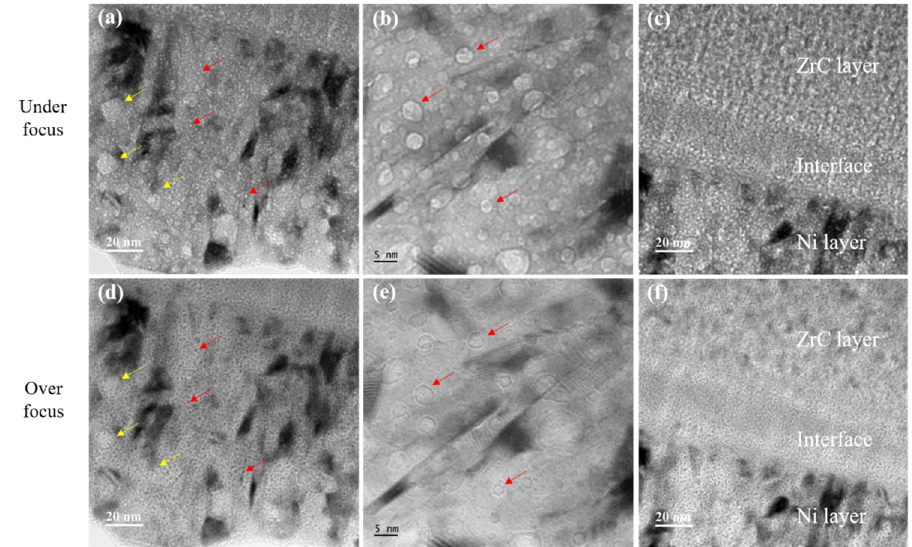
Figure 8. ( a , d ) The TEM bright-field images and ( b , e ) high-magnification TEM images of the crys- talline Ni layer after irradiation. ( c , f ) The distribution of helium bubbles in the three regions under the TEM bright-field images. The red and yellow arrows indicate the helium bubbles with different size. ( a – c ) Under-focus and ( d – f ) over-focus.